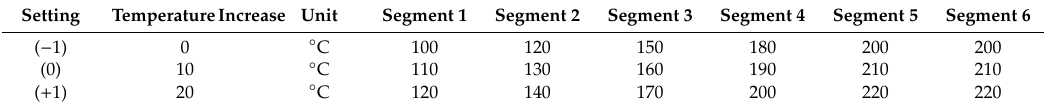
Table 2. Factors studied and factor levels used in the